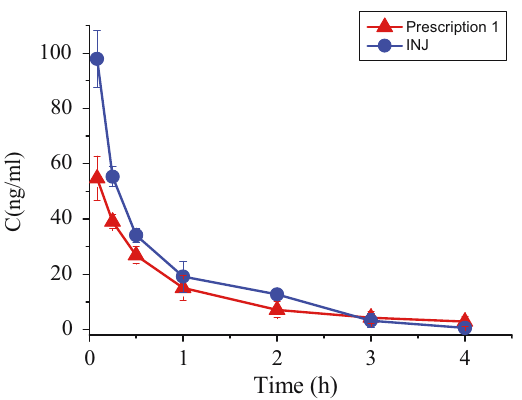
Figure 8: Comparison of sustained release between prescription 1 and the commercial